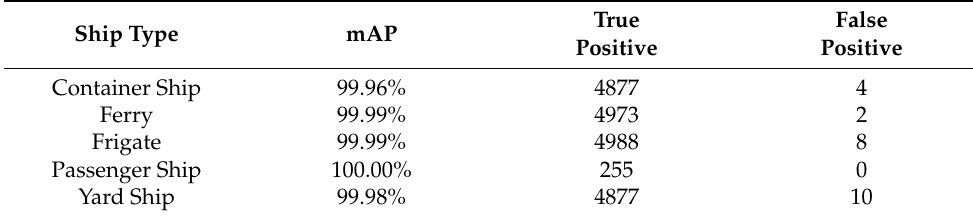
Table 2. Results of Mean Average Precision